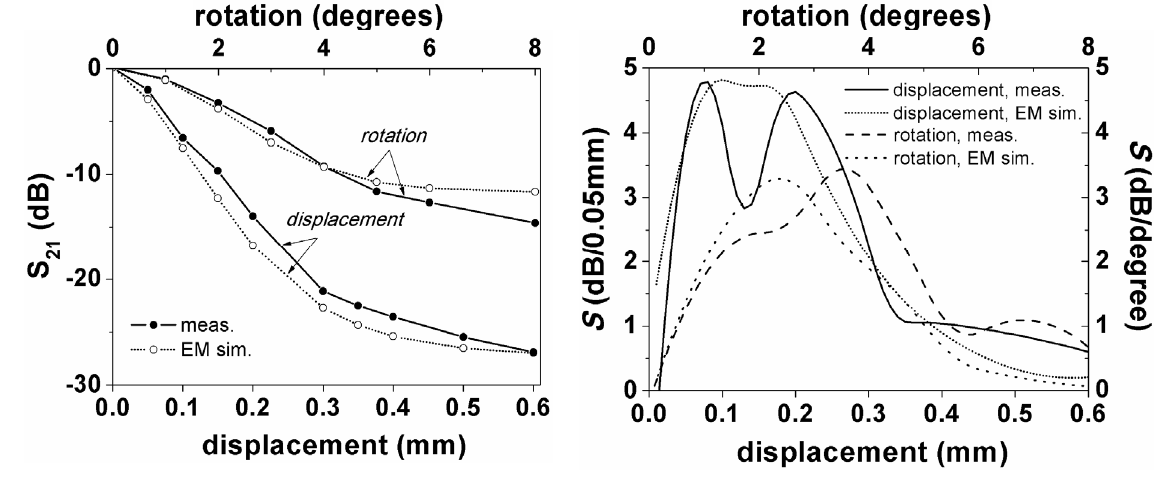
Figure 8. ( a ) Insertion loss at first resonance and ( b ) sensitivity of the insertion